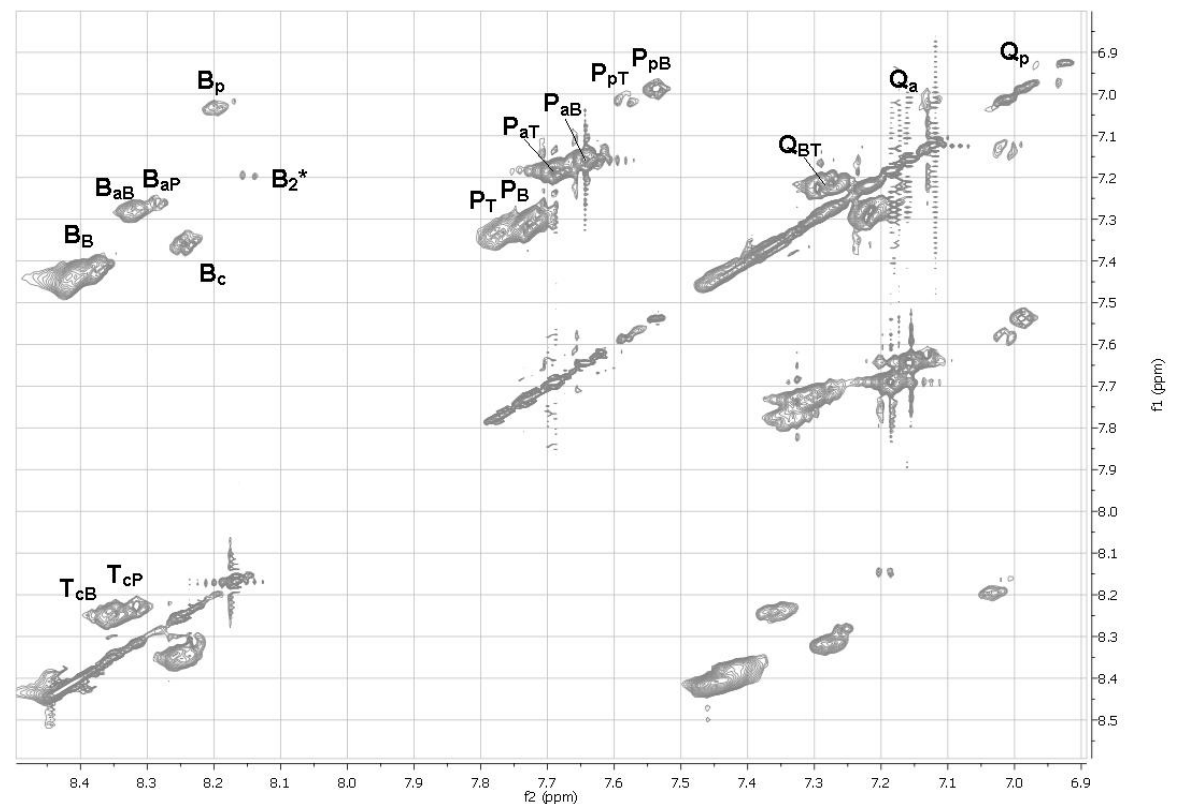
Figure 7. 1 H TOCSY NMR spectrum of HFIP extract of polymer 1.